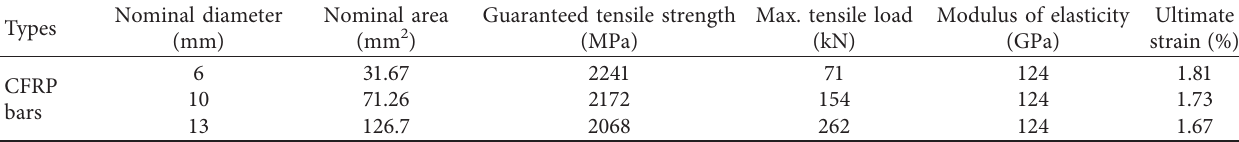
Table 1: Physical properties of CFRP bars